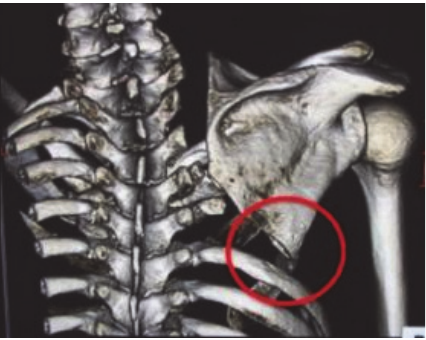
Figure 5: Postoperative CT: locking symptoms improved after resection of the inferior angle of the